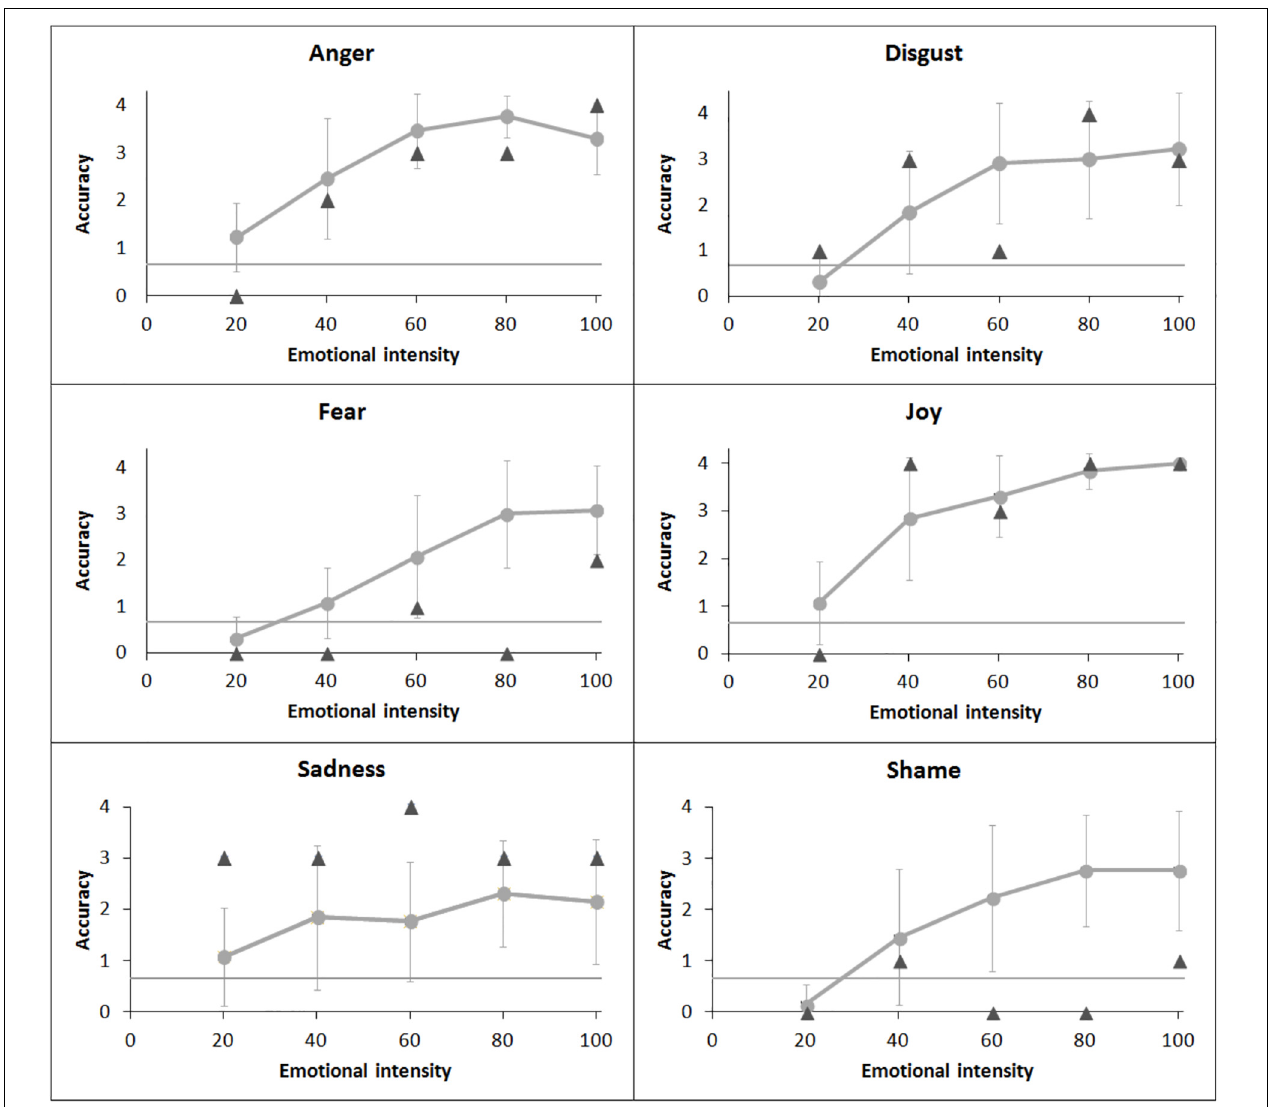
FIGURE 3 | Patient’s (dark gray triangle) performance and healthy controls’ (light gray dot) mean performance on emotional facial recognition task. Bars indicate standard deviations.